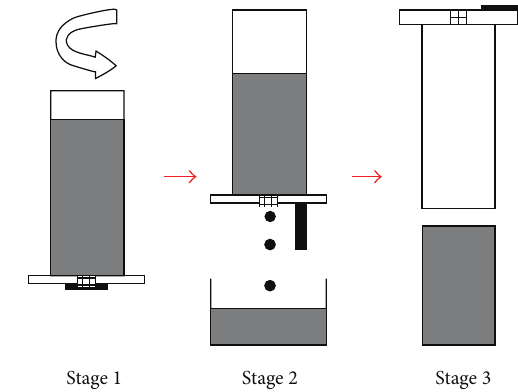
Figure 18: Schematic diagram of preparation procedure of slug in the SEED process [44].